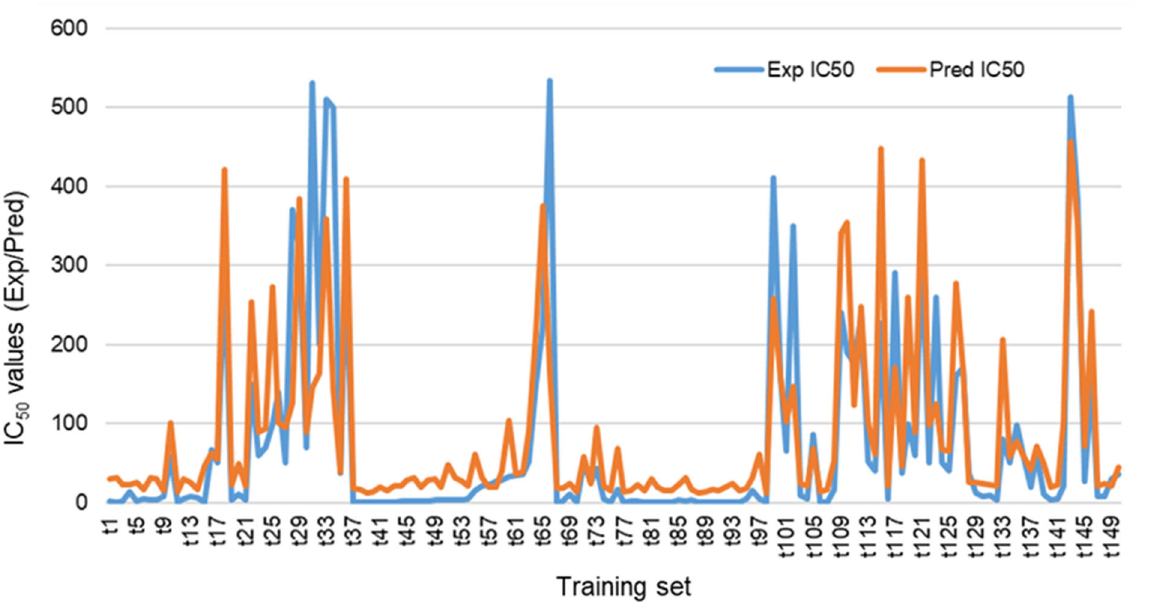
Figure 5. Overview of the graphical presentation of PDE5 IC 50 of training set ( t1 – 150 ) shows correlation between the experimental (blue color) and predicted (red color) IC 50 values.